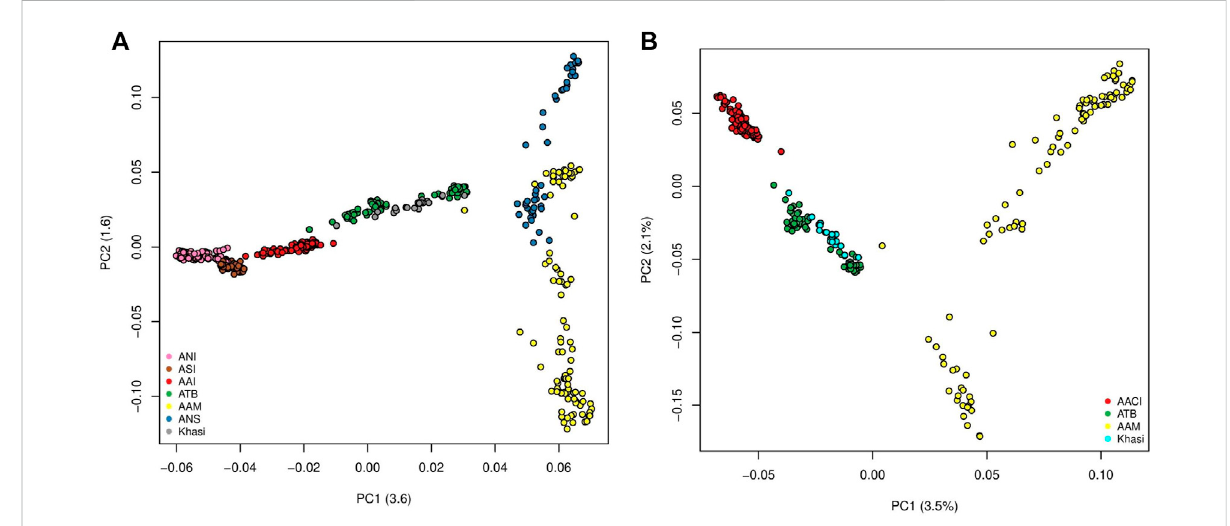
FIGURE 1 (A) PCA on Mainland Indian and Malaysian populations (ANI: Ancestral North Indian, ASI: Ancestral South Indian, AACI: Austroasiatics of Central India, ATB: Ancestral Tibeto Burmans, AAM: Austroasiatics of Malaysia, ANS: Austronesians); (B) PCA on the Austroasiatics and the Tibeto